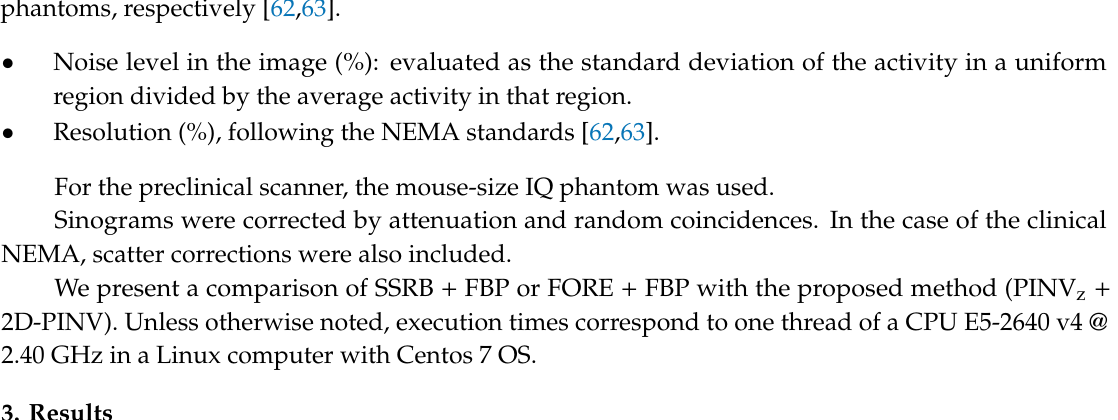
Figure 6. Axial profile of a simulated thin-slice (XX mm slices thickness) Defrise phantom for the SuperArgus scanner reconstructed from the three rebinning methods ( top ) and a profile along the axis of the scanner ( bottom ), that is, along the yellow line in the top panel. PINVz rebinning employed 20 iterations.